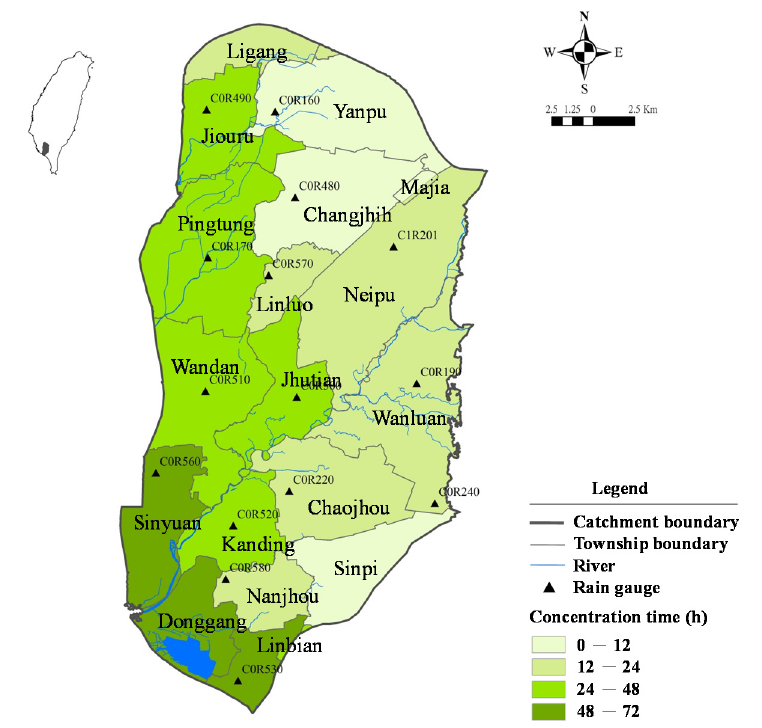
Figure 4. Distribution of rain gauges, townships, and township-averaged concentration time for Pingtung